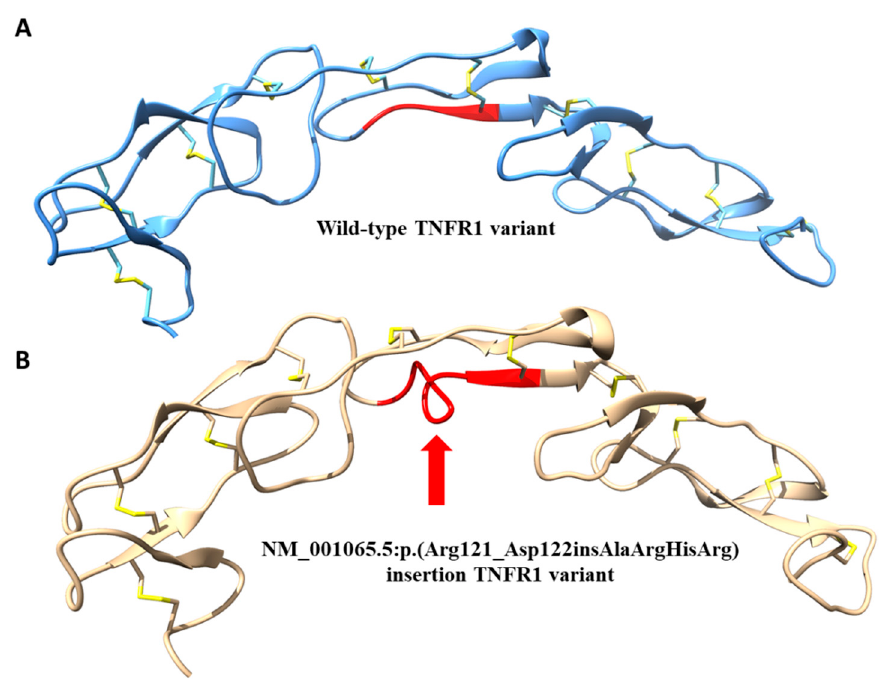
Figure 2. ( A , B ) Comparison between the structure of wild-type variant of TNFR1 protein ( A ) and modeling of the predicted misfolding (red arrow) resulting from the NM_001065.5: p.(Arg121_Asp122insAlaArgHisArg) insertion in the pathogenic variant of TNFR1 ( B ).